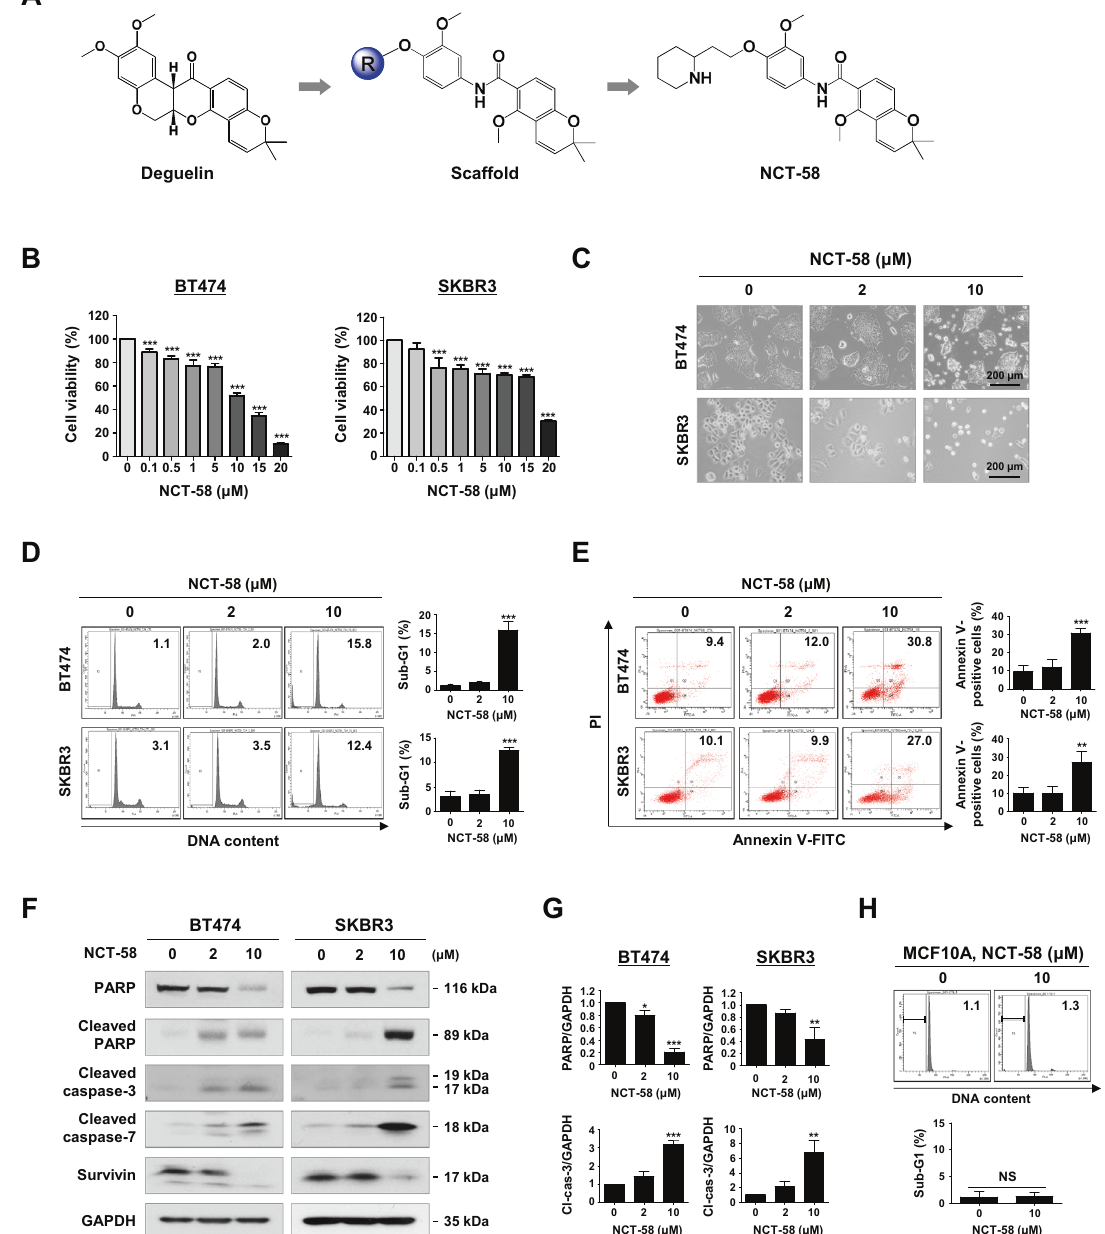
Fig. 1 NCT-58 reduces cell viability and induces apoptosis in HER2-positive breast cancer cells. A Chemical structure of deguelin and NCT- 58. B BT474 and SKBR3 cells were treated with various concentrations of NCT-58 (0.1 – 20 μ M) or DMSO (solvent control) for 72 h. Cell viability was determined by MTS assay (*** p < 0.001, n = 4). C Morphological changes of BT474 and SKBR3 cells after treatment with NCT-58 (2 – 10 μ M, for 72 h) as seen through phase-contrast microscopy. D Cells were treated with NCT-58 (2 – 10 μ M) for 72 h and the sub-G1 population was assessed by fl ow cytometry (*** p < 0.01, n = 3). E Early and late apoptotic cells in the presence or absence of NCT-58 were quanti fi ed by annexin V/PI staining (right panel, ** p < 0.01; *** p < 0.001, n = 3). F Effect of NCT-58 on expression of cleaved-caspase-3, cleaved-caspase-7, cleaved-PARP and survivin in BT474 and SKBR3 cells. G Quantitative graphs of these protein levels (* p < 0.05; ** p < 0.01; *** p < 0.001, n = 3). GAPDH was used as an internal loading control. H The sub-G1 fraction of the normal human mammary epithelial MCF10A cells was analyzed through fl ow cytometry after exposure to 10 μ M of NCT-58 for 72 h (NS, not signi fi cant, versus DMSO control, n = 3). The results are presented as mean ± SD of at least three independent experiments and analyzed by one-way ANOVA or Student ’ s t -test followed by Bonferroni ’ s post hoc test. RESULTS which is a naturally occurring C-terminal inhibitor (Fig. 1A). NCT-58-dependent apoptosis is mediated by caspase NCT-58 speci fi cally binds to the C-terminal domain of HSP90 activation in HER2-positive breast cancer cells and was identi fi ed through a molecular docking study [29]. We We fi rst sought to evaluate the effect of NCT-58 on cell viability sought to further evaluate its ef fi cacy against cancer stem cells and apoptosis in HER2-positive breast cancer cells. NCT-58 in trastuzumab-resistant HER2-positive breast cancer.